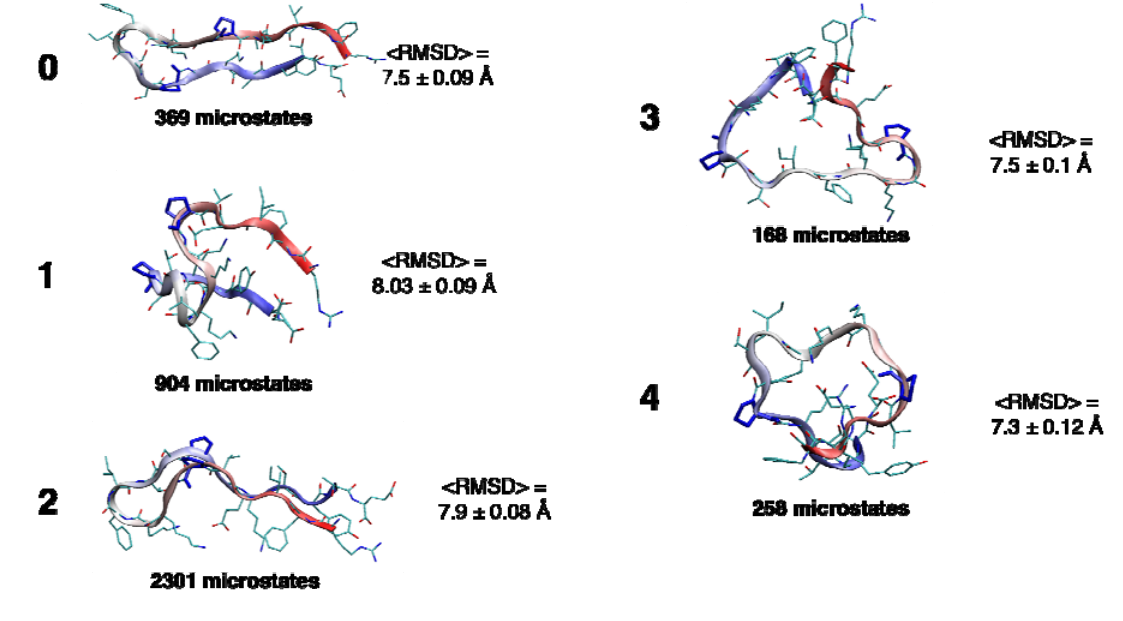
Figure 10. Kinetics-based clustering was used to find five maximally metastable macrostates (see Methods). The representative conformations shown for each state are the most probable conformations in that state. Shown next to each representative conformation is the average RMSD between microstates in that cluster, a measure of the compactness of the conformational ensemble, and the number of microstates (of 4000 total) comprising each